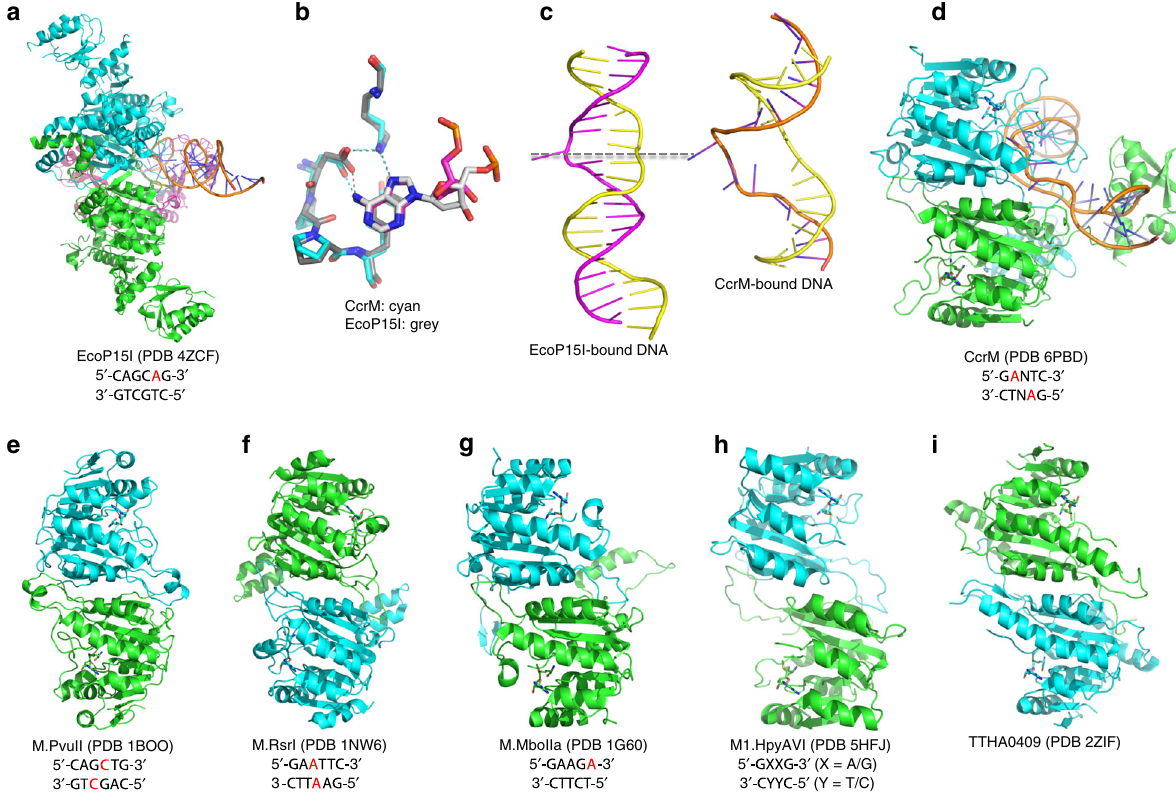
Fig. 6 Conserved dimer formation in β -class amino MTases. a EcoP15I (PDB 4ZCF). b Superimposition of EcoP15I and CcrM results in a conserved active- site con fi guration for adenine. c Two very different DNA conformations in the EcoP15I-bound (left) and CcrM-bound (right). Except for the target adenine, the EcoP15I-bound DNA conformation has intact intra-helical bases. d CcrM (PDB 6PBD). e M.PvuII (PDB 1BOO) on cytosine – N4 methylation. f M.RsrI (PDB 1NW6). g M.MboIIA (PDB 1G60). h M1.HpyAVI from Helicobacter pylori (PDB 5HFJ). i TTHA0409 from Thermus thermophilus HB8 (PDB